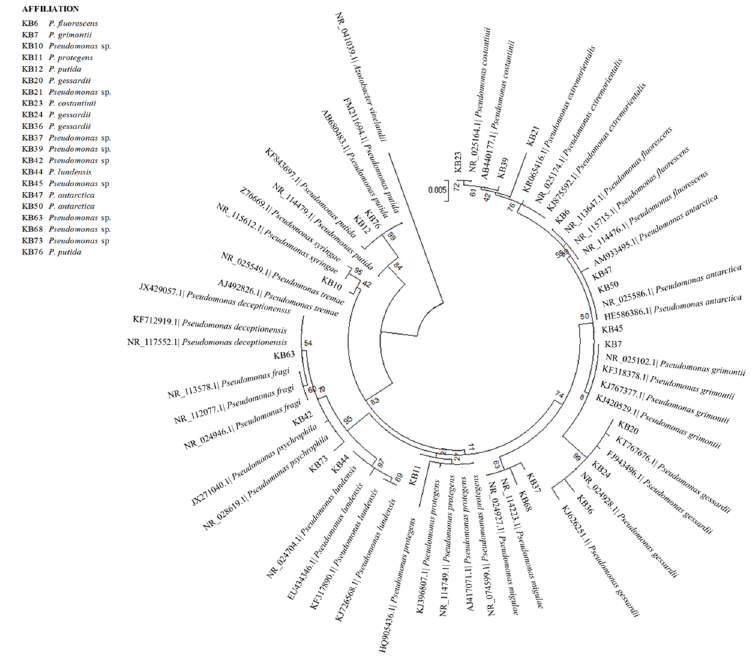
Fig 2. Maximum Likelihood phylogenetic dendrograms of KB strains belonged to Pseudomonas based on 16S rDNA sequences. Bootstrap values calculatedfor 1000 replications(values lower than 50 are not shown). Bar, 5 nt substitution per 1000